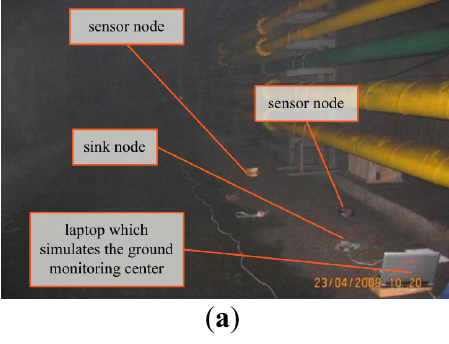
Figure 7. ( a ) Testing scenario in an underground coal mine; ( b ) Deployment of